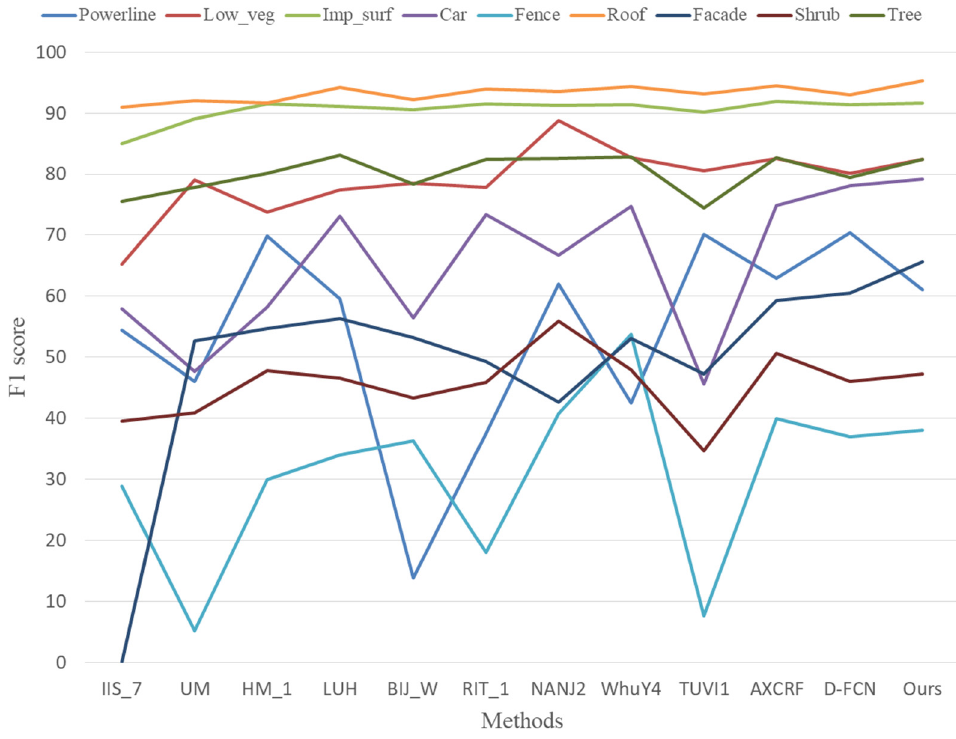
Figure 11. F1 score for each category of different methods in Vaihingen 3D data.